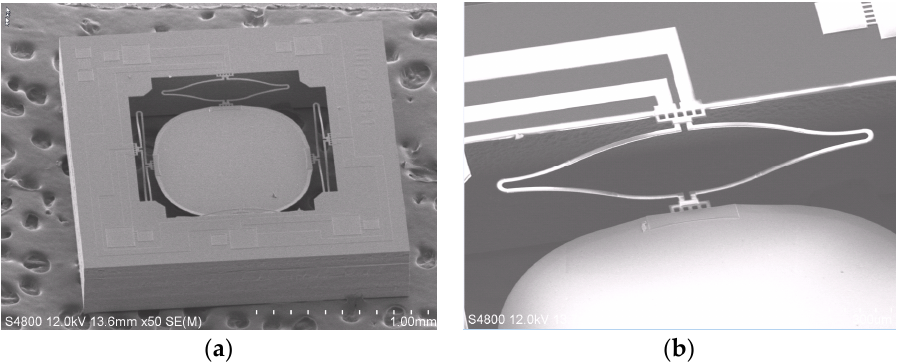
Figure 2. Two-axis ISC MEMS mirror. ( a ) Scanning electron microgram (SEM) of a fabricated device (2mm × 2mm); ( b ) SEM of an ISC actuator.